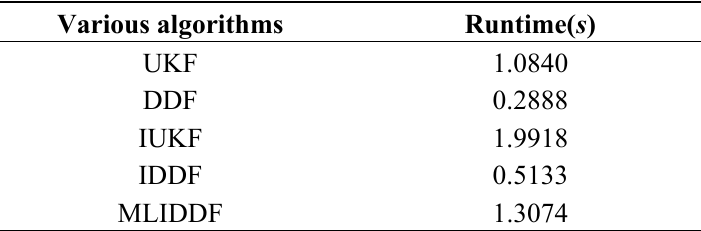
Table 3. Runtimes of various